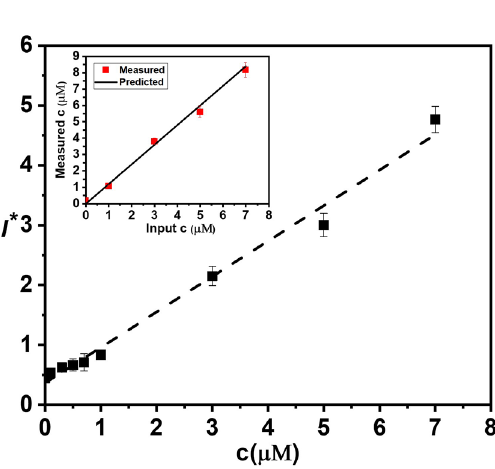
Figure 5. Variation of FL intensity with H 2 O 2 concentration in human whole plasma at 1:6 dilution, measured using the integrated microfluidic device with on-chip blood plasma separation and on-chip mixing/incubation), 2 = 0.99 a linear fit is obtained with R . Inset shows a comparison of the input H 2 O 2 concentrations and 2 = 0.98 predicted H 2 O 2 concentrations from FL measurements, which also shows a linear fit with R . (Each data point represents the standard deviation (SD) from three different